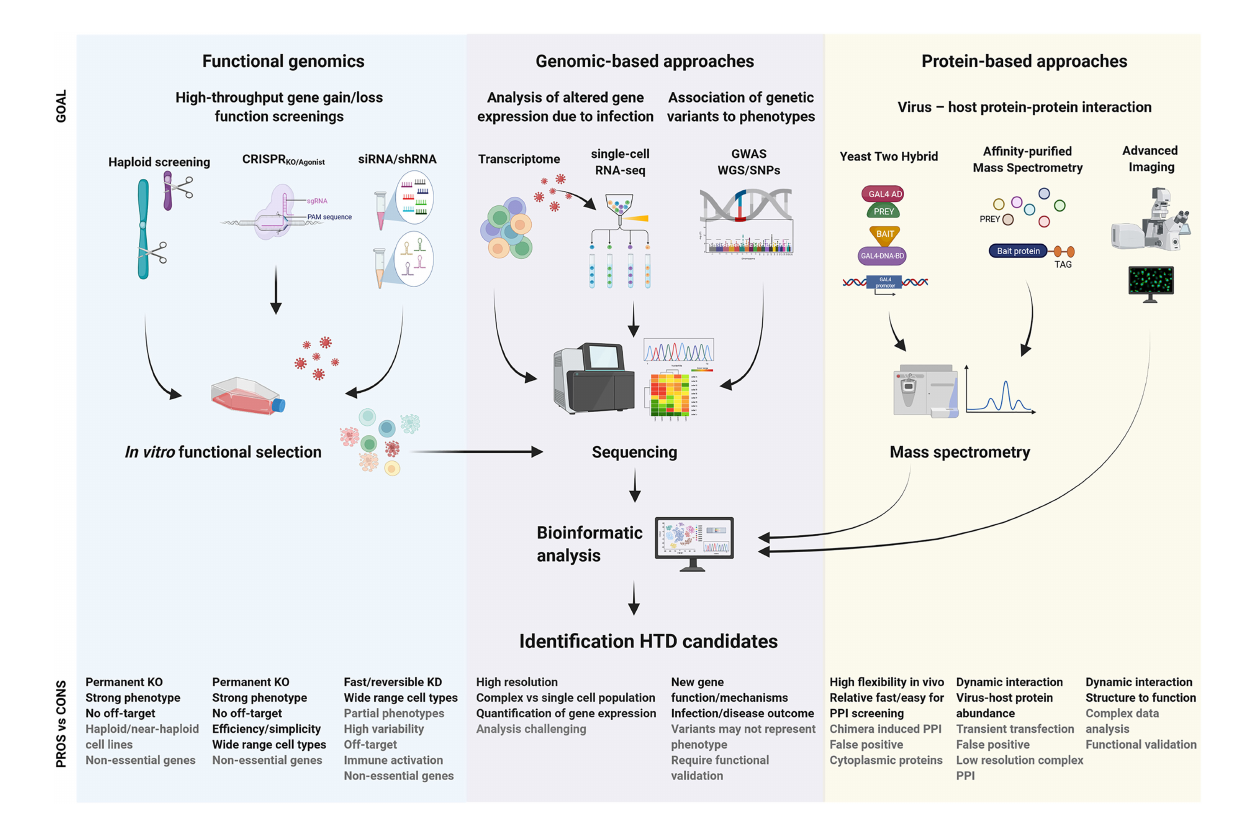
FIGURE 1 | Summary of milestones for the identi fi cation of viral host dependency factors and development of host-based therapeutic intervention. The expected purpose of outcome information of each technique is described as “ goal ” in the fi gure. The advantages and disadvantages are indicated as “ pros vs cons ” . Whole- genome sequencing, WGO; single nucleotide polymorphism, SNP; genome-wide association studies, GWAS; knock-out, KO; knock-down, KD; protein-protein interaction,